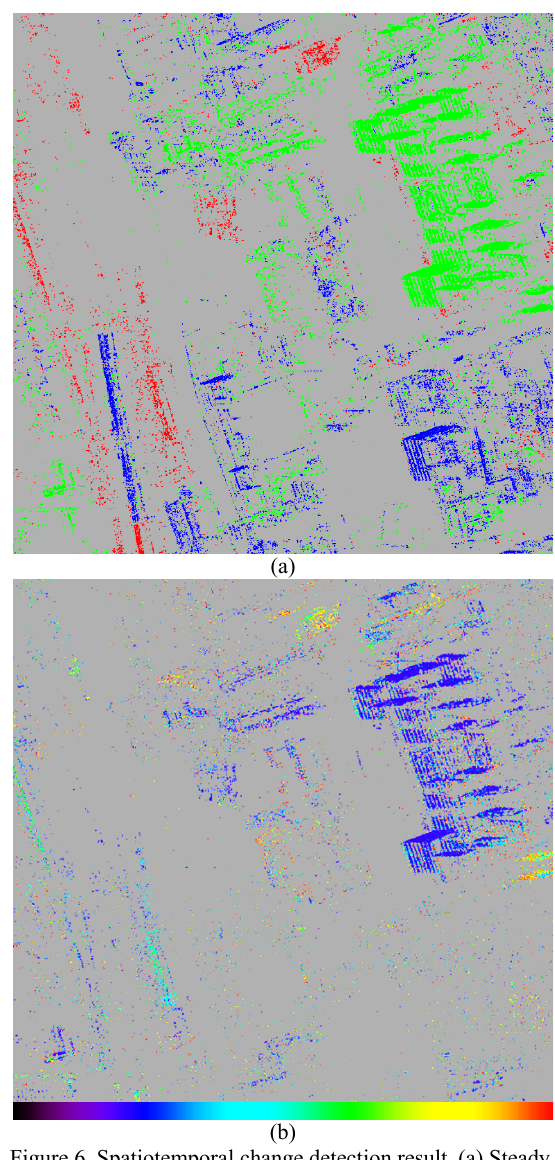
Figure 6. Spatiotemporal change detection result. (a) Steady, disappearing, and emerging structures represented by PS (blue), DBC (red), and EBC (green) points. (b) Occurrence dates: black to red, earliest to latest in